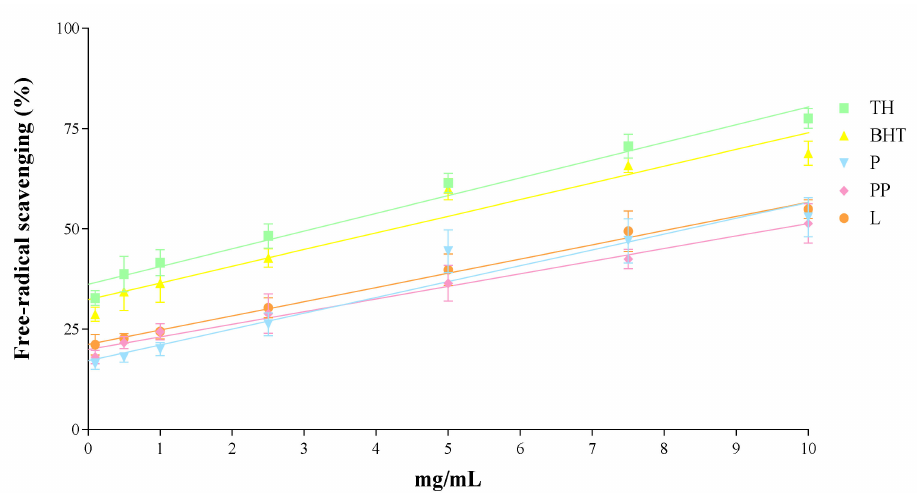
Figure 5. Antioxidant activity of TH, BHT and surface compounds alone (P, PP and L) assessed by the DPPH free-radical scavenging assay. The 100% ROS was obtained by the value of the control (H 2 O 2 ) in 2 h.